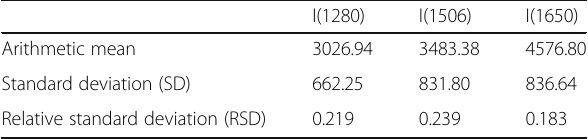
Table 1 Intensity statistics of the main peaks (1280 cm − 1 , 1506 cm − 1 , and 1650 cm − 1 ) of Rhodamine B collected from 20 spots randomly